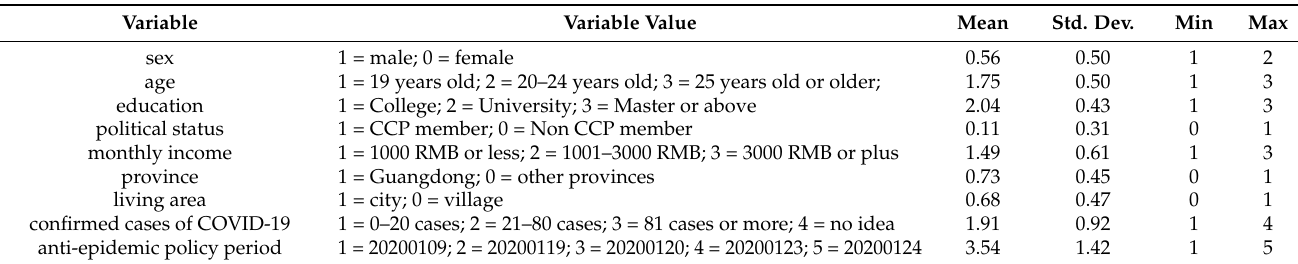
Table 2. Descriptive statistics of the